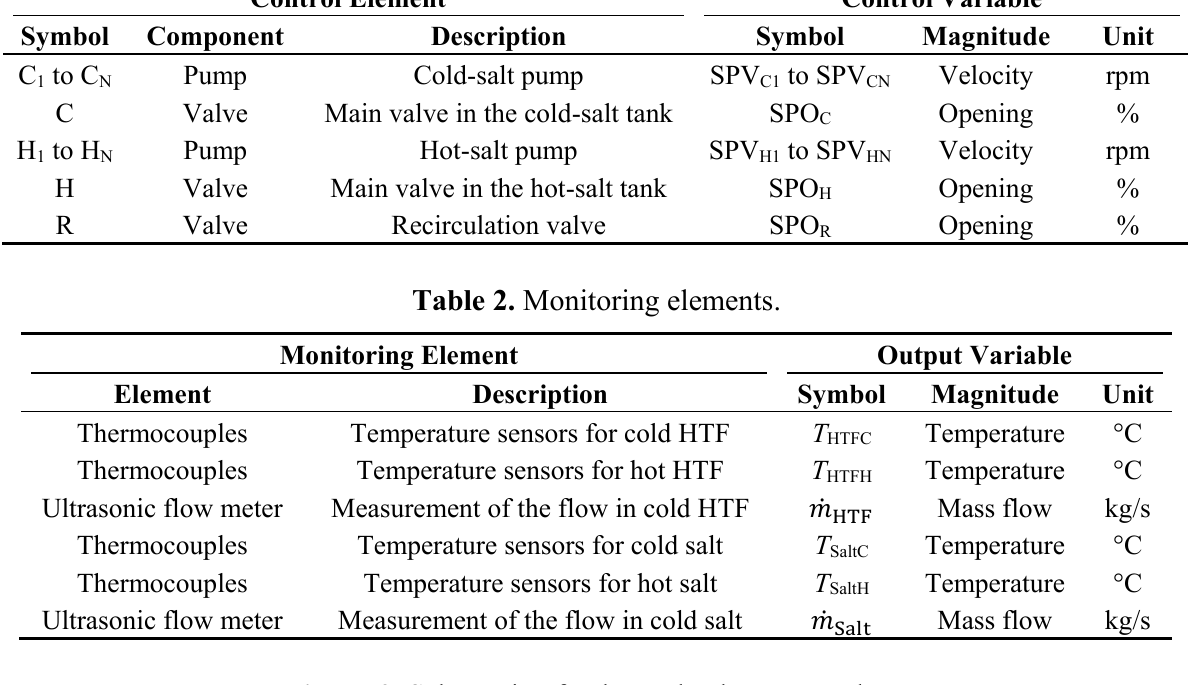
Figure 3. Schematic of a thermal solar power